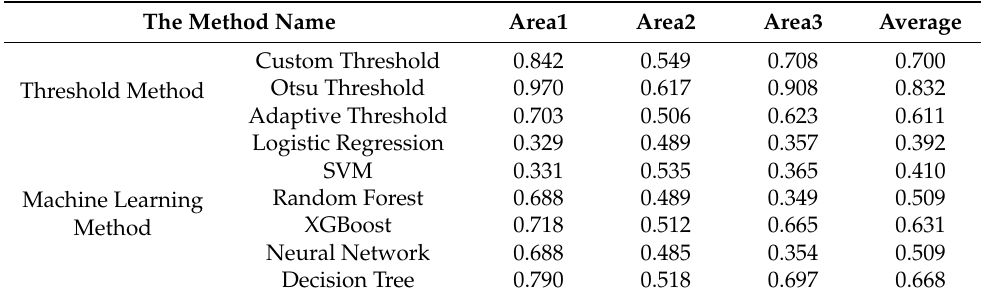
Table A5. AUC index statistics of each algorithm in three regions on October